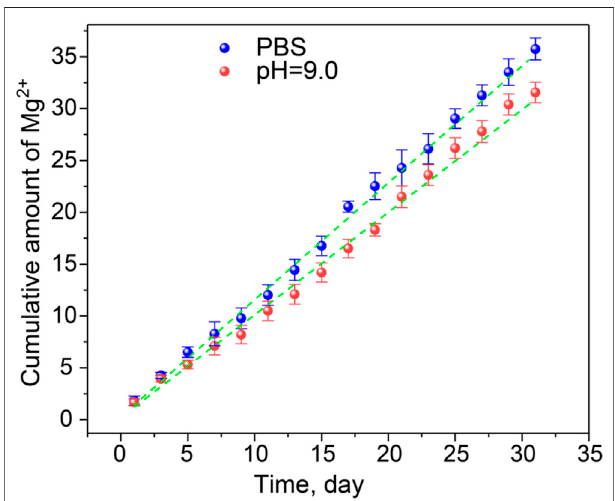
FIGURE 3| The release curveof Mg 2+ from Mg 2+ @GG/PAM hydrogel in PBS (blue dotted), pH (cid:1) 9.0 solution (red dotted), and Korsmeyer – Peppas fi t curve (green dotted line). The values are represented as mean ± SD ( n (cid:1) 4).